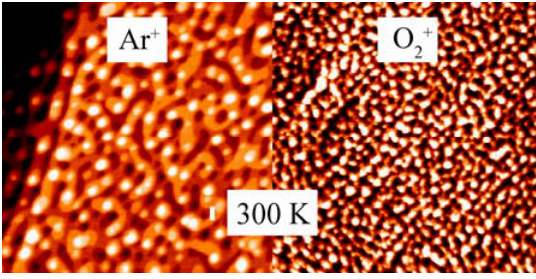
Figure 3. STM images (200 nm × 200 nm) collected from Au(111) surfaces after bombardment with 500 eV argon (left) and oxygen (right) ions (fluence ~3 × 10 15 ions/cm 2 ) at room temperature. Note the smaller length scale of the oxygen-ion-induced surface